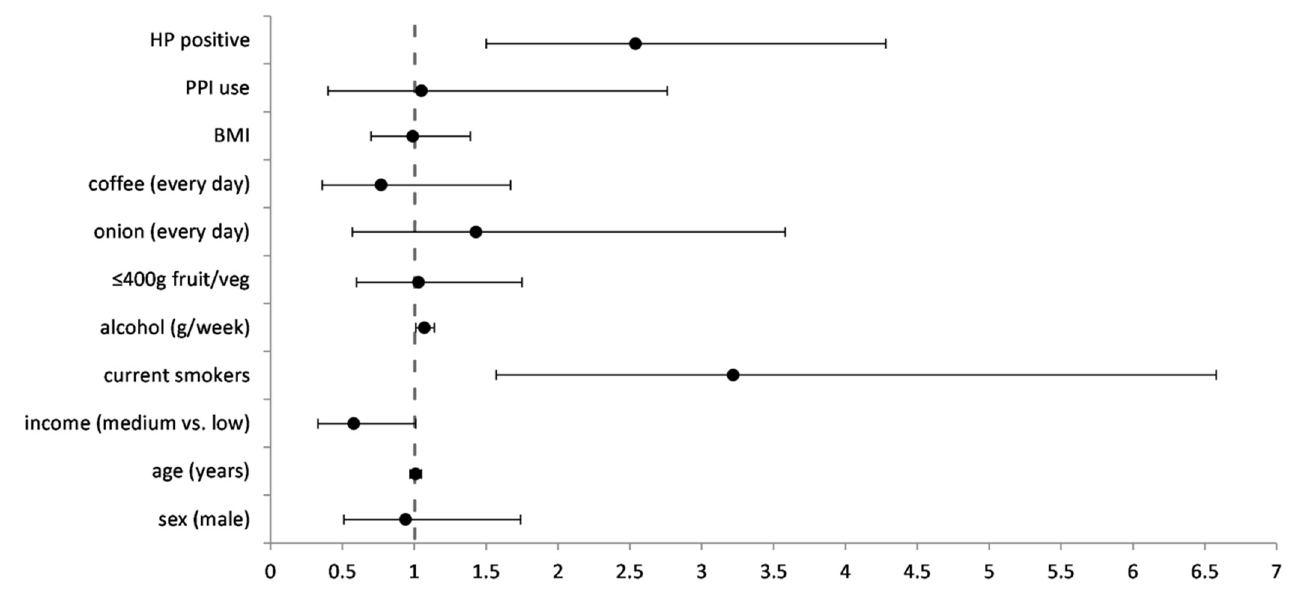
Figure 1. Multivariable regression model for false negative cases in detecting precancerous gastric lesions with pepsinogen testing ( n = 293). FN was compared against TP. OR—odds ratio, adjusted for all the factors in the model, CI—confidence interval, HP— Helicobacter pylori , PPI—proton pump inhibitor, BMI—body mass index.